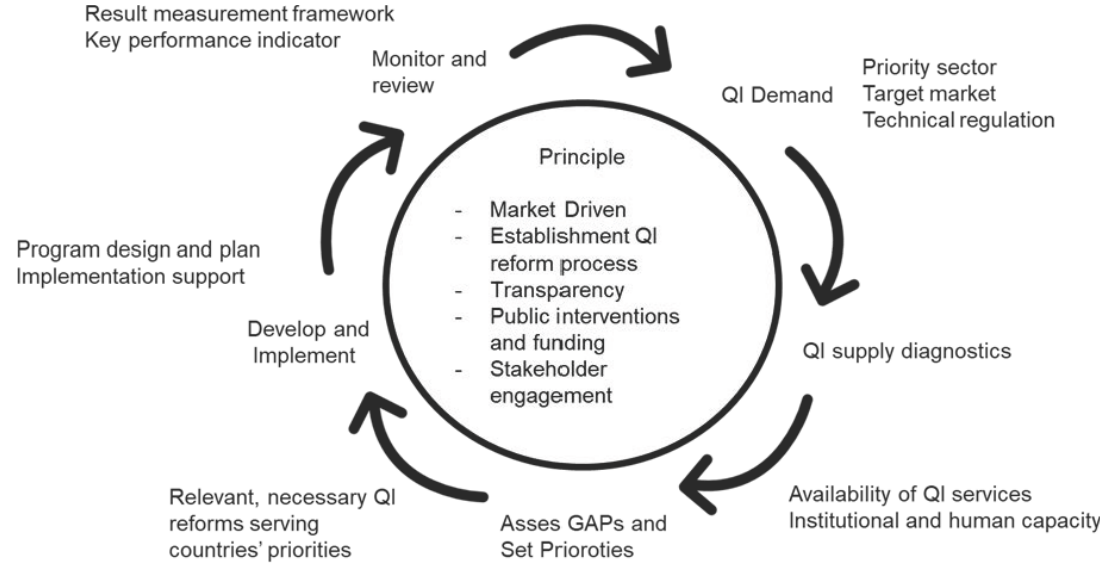
Figure 10: QI development cycle